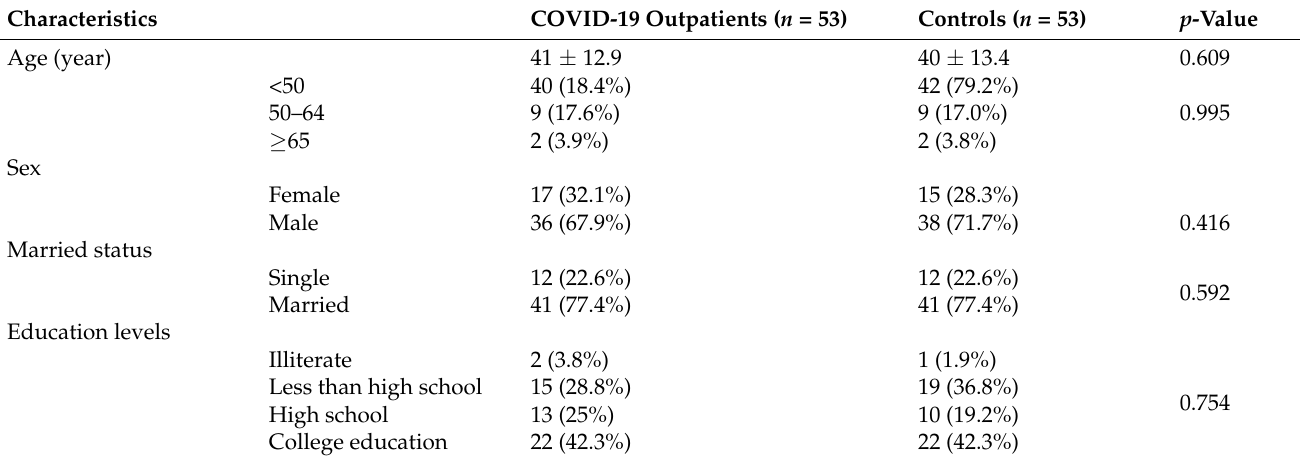
Table 1. Demographic, clinical, anthropometric, and laboratory characteristics of patients infected with COVID-19 and matched controls at baseline †